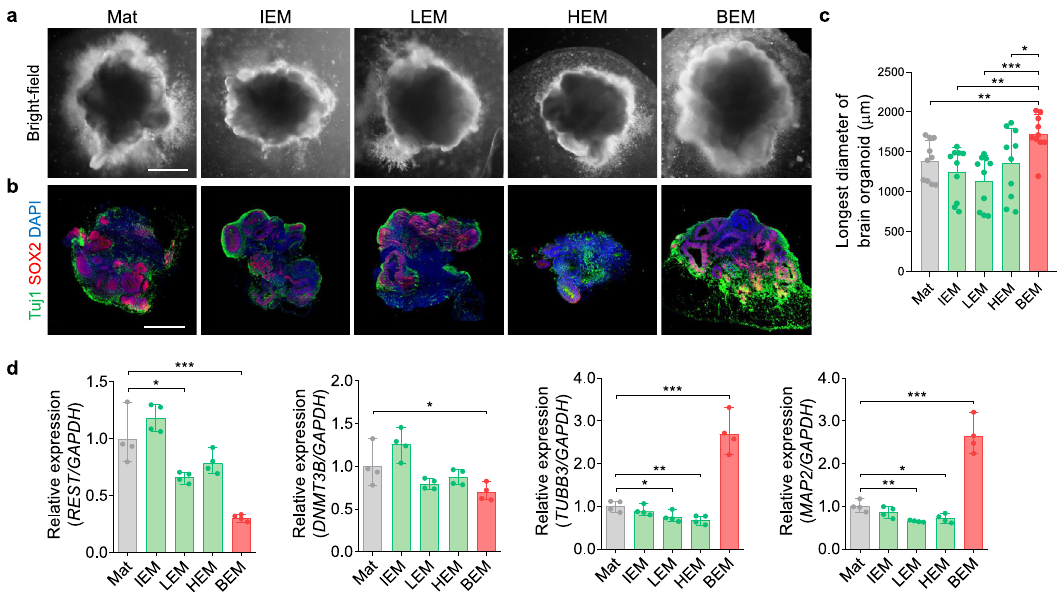
Fig. 4 The tissue-speci fi c effects of 3D ECM hydrogels on brain organoid development. a Bright- fi eld images of brain organoids encapsulated in ECM hydrogels derived from different decellularized organs [brain (BEM), intestine (IEM), liver (LEM), and heart (HEM)] at day 30 (scale bars = 500 μ m). b Immunostaining of brain organoids on day 30 for Tuj1 and SOX2 (scale bars = 500 μ m). c Image-based quanti fi cation of the longest diameter of brain organoid at day 30 ( n = 10 per group, BEM versus Mat p = 0.0069, BEM versus IEM p = 0.0013, BEM versus LEM p = 0.0002, BEM versus HEM p = 0.0301). d The gene expression analysis of brain organoids at day 30 by qPCR for transcriptional factors ( REST , DNMT3B ) and neuronal markers ( TUBB3 , MAP2 ) ( n = 4 per group, Mat versus LEM p = 0.025, Mat versus BEM p = 0.0009 for REST ; Mat versus BEM p = 0.0498 for DNMT3B ; Mat versus LEM p = 0.031, Mat versus HEM p = 0.0085, Mat versus BEM p = 0.0004 for TUBB3 ; Mat versus LEM p = 0.0017, Mat versus HEM p = 0.0128, Mat versus BEM p = 0.0003 for MAP2 ). Mat and BEM organoids were cultured in a dish on an orbital shaker. All quantitative data are expressed as mean ± SD. Statistical differences between the groups were determined by unpaired two-tailed t -test (* p < 0.05, ** p < 0.01, *** p < 0.001). Independent replicates for all data in ( a – d ) = 4. Source data are provided as a Source Data fi